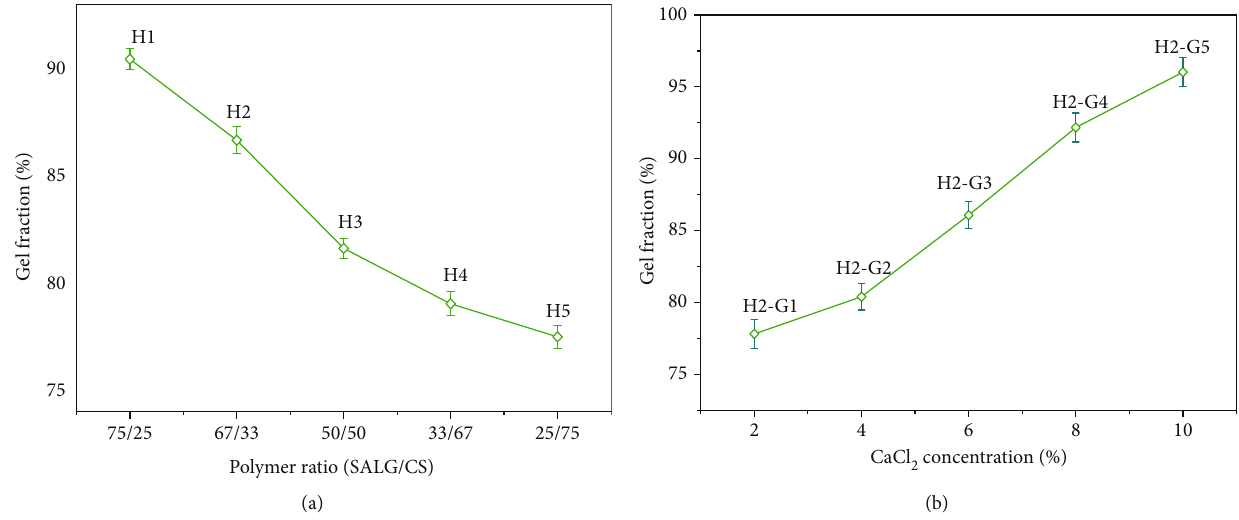
Figure 7: Gel fraction of (a) hydrogels H1 to H5 as a function of CS/PVP ratio and (b) hydrogels H2-G1 to H2-G5 as a function of glutaraldehyde content.